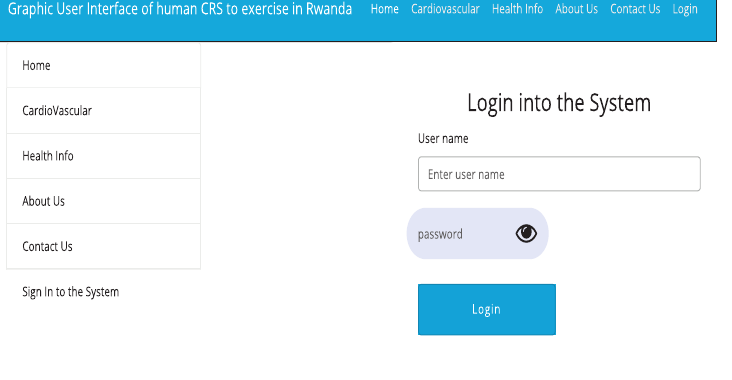
Figure 6: Login page in ICRSMM.